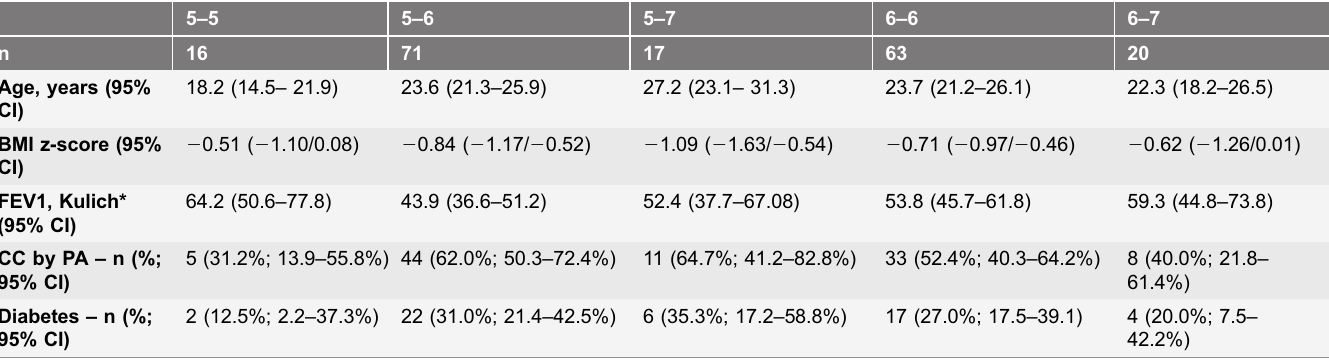
Table 2. Clinical data of 187 Cystic Fibrosis patients homozygous for the F508del mutation according to the genotype for the MIF gene -CATT repeat at position 2